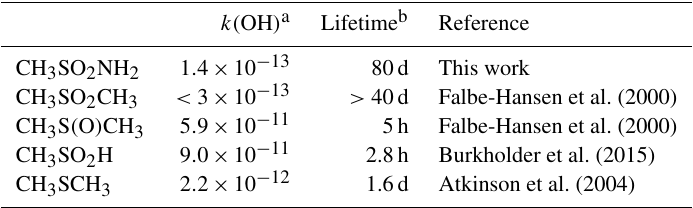
Table 3. Lifetimes of atmospheric organosulfur trace gases with respect to reaction with OH. k( OH ) a Lifetime b